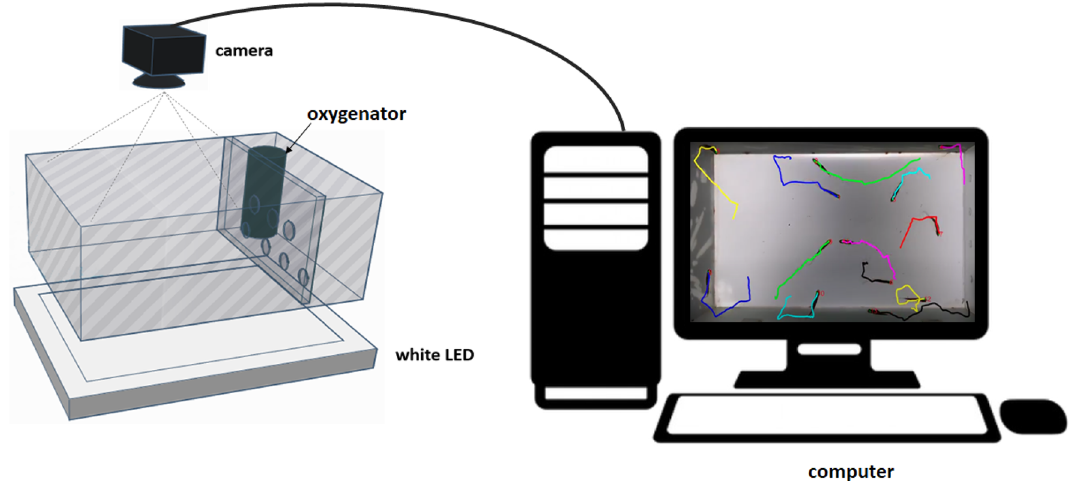
Figure 1. Experiment setup. The groups of zebrafish swam in a sandblasted glass tank (left), placed horizontally above a white LED panel. A camera was mounted above the tank. The images were captured and processed by the computer